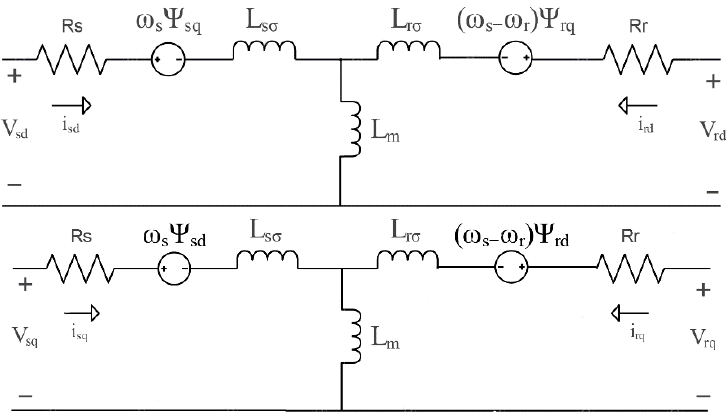
Figure 3. DFIG: d and q axis equivalent